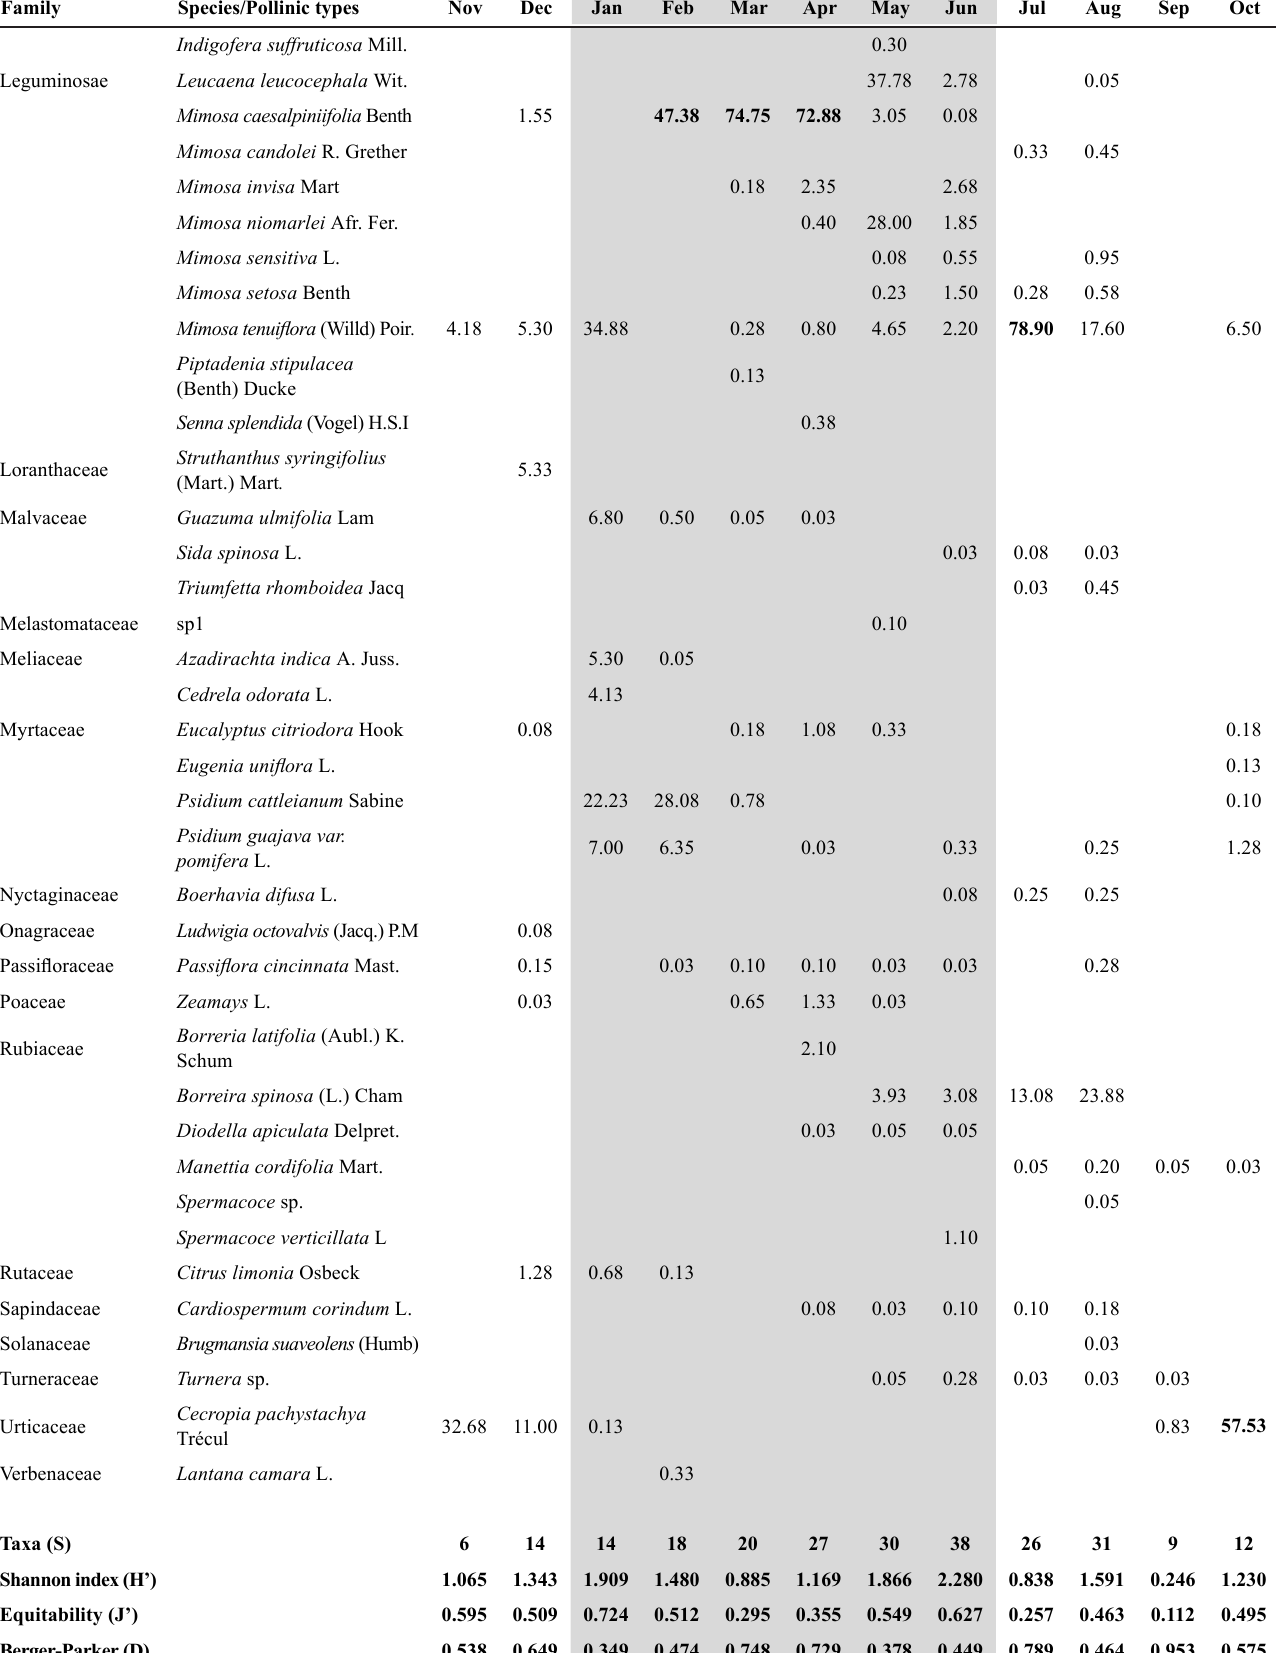
Table 1 . Temporal variation in the diet of Apis mellifera in a seasonal semideciduous forest in the State of Ceará, in the period from November 2012 to October 2013. Months highlighted in gray correspond to the rainy season and months highlighted in white represent the dry season. The values in each month correspond to the percentage of each plant species of the whole pollen collected during each month.